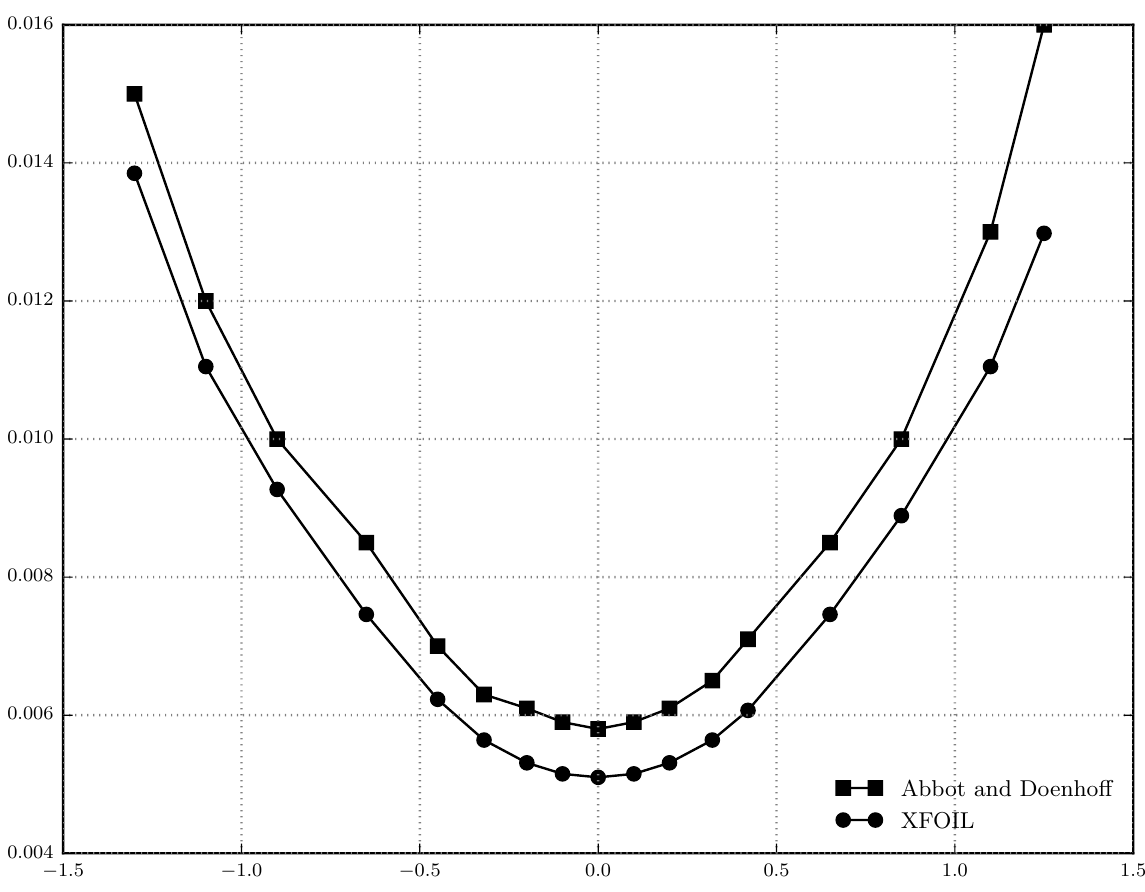
Figure 4. A comparison between experimental results [20] and XFOIL for an NACA 0012 aerofoil at RE= 3 × 10 6 , with natural